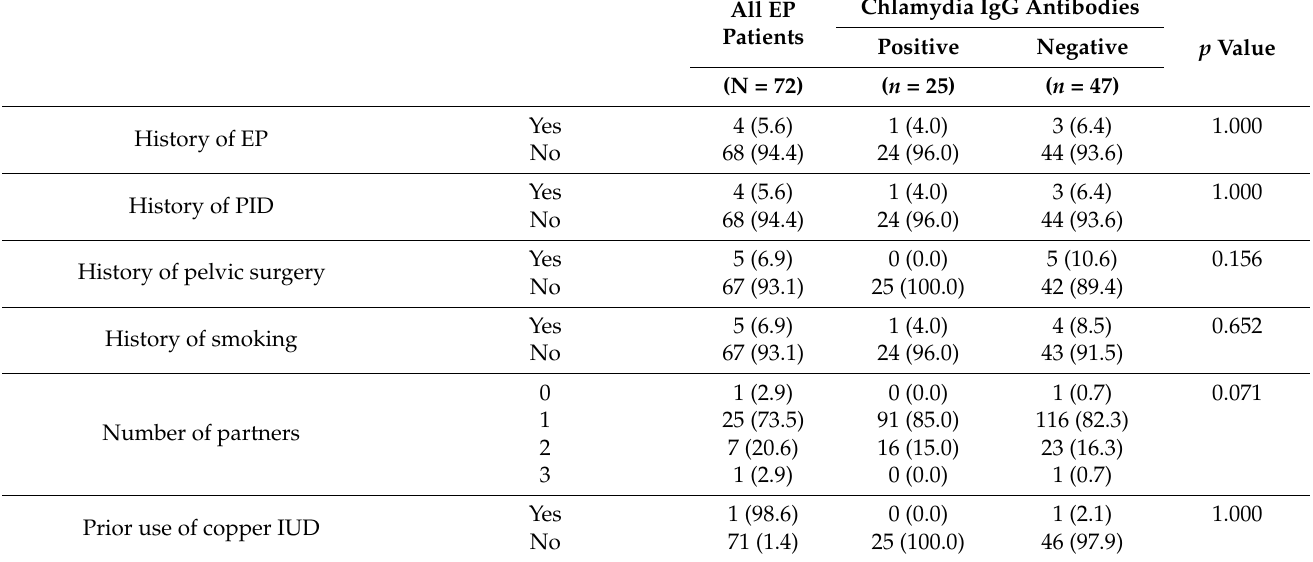
Table 4. Association between ectopic pregnancy-related characteristics and chlamydia IgG antibodies ( n =